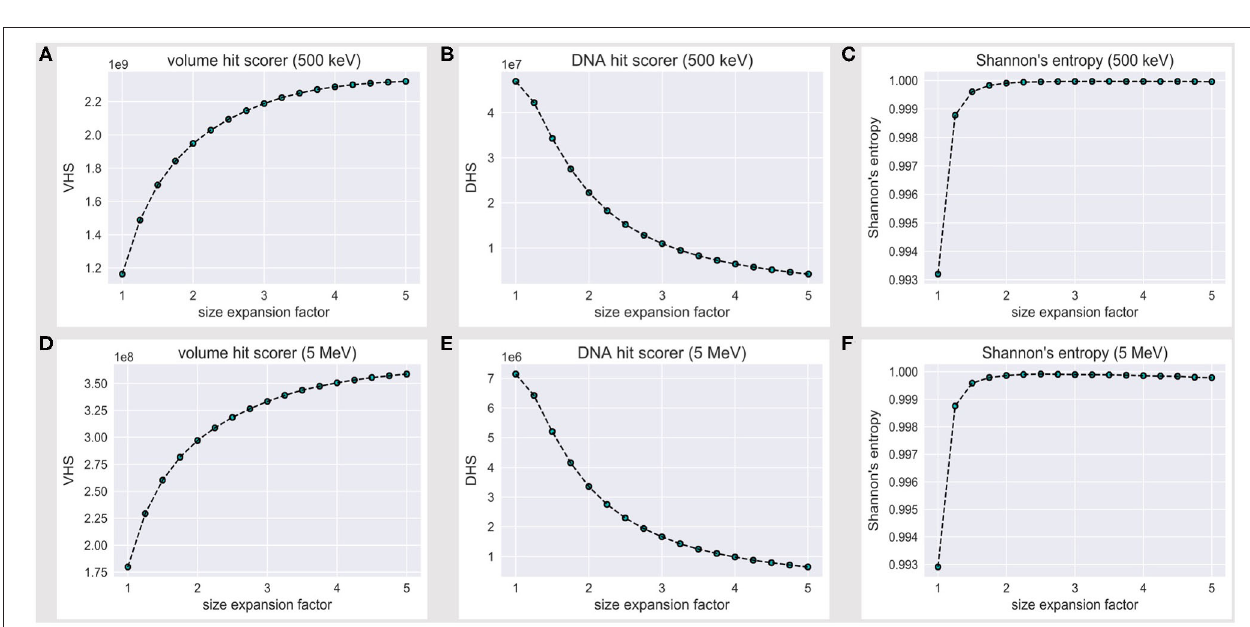
FIGURE 2 | Hit score over the z-axis [as defined in the nucleosome tetramer Protein Data Bank (PDB) atom coordinates file] to all dose deposition events within the reference volume frame, for a set of 500 keV-protons PDB4DNA runs at a (A) 1-fold, (B) 2.5-fold, and (C) 5-fold linear expansion of the reference volume sizes; the reference volume is oversampled at its core, whereas the disparity to the outlying compartments is explicit to smaller systems (hit artifact).